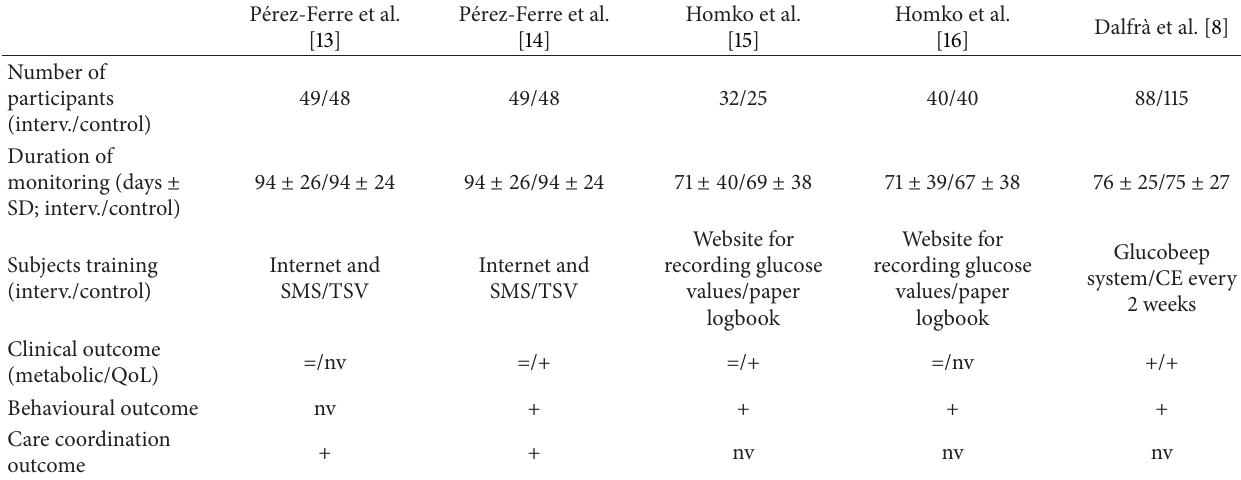
Table 2: Brief summary of the main outcomes of the studies conducted in pregnant women with